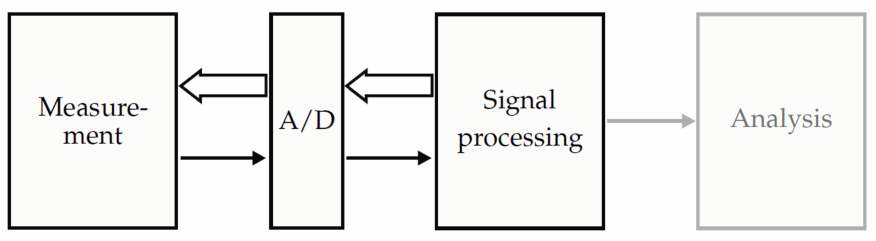
Figure 1. General overview of a medical system operating with magnetic sensors. The measurements are performed simultaneously with localizing the sensors. After transforming the signals into the digital domain, the signals are processed and analyzed. Since the analysis of the measured magnetic signals is not in the focus of this contribution, the corresponding box is depicted in